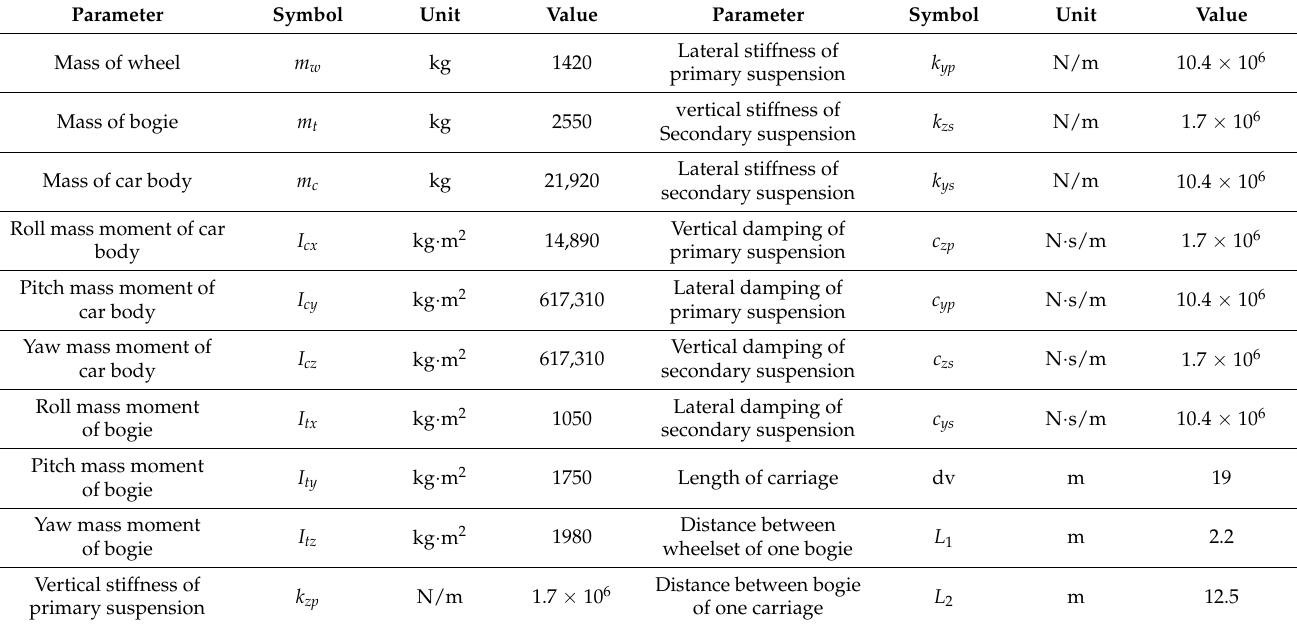
Table 3. Vehicle